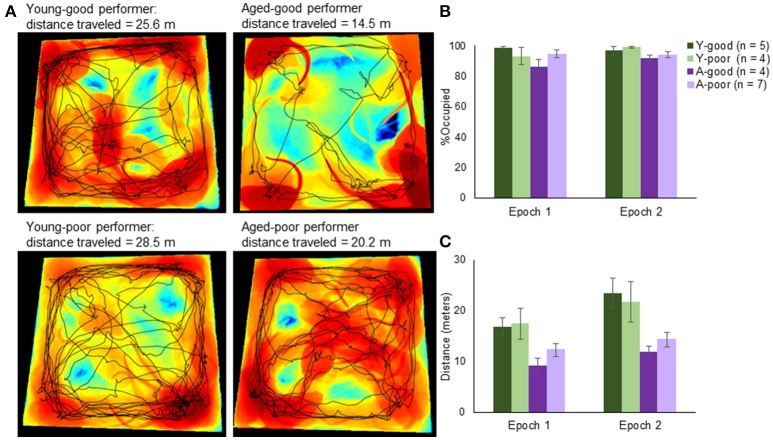
Arena exploration performance. (A) Representative occupancy heat maps and travel paths across age and behavioral group. Occupancy maps were created using custom computer vision software written in MATLAB. Briefly, background subtraction allowed a segmented representation of the total area that the rat occupied within a single frame (from nose to tail and everything in between). Black areas represent areas unexplored by the animal, blue is low occupancy and red is high occupancy. Superimposed on top of the occupancy heat map is the exploration path (black line). (B) Quantifying the total area across rats, there was no significant difference in novel area coverage across groups. (C) There was, however, a significant difference in the total distance traveled with rats traveling farther in the second epoch relative to the first. Moreover, consistent with slower ambulation velocities with age, the aged animals had lower cumulative path-lengths.